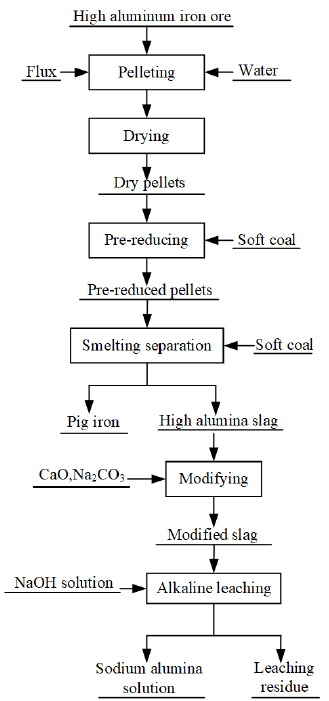
Figure 3. Experiment flow sheet of the proposed HAIO treatment process.